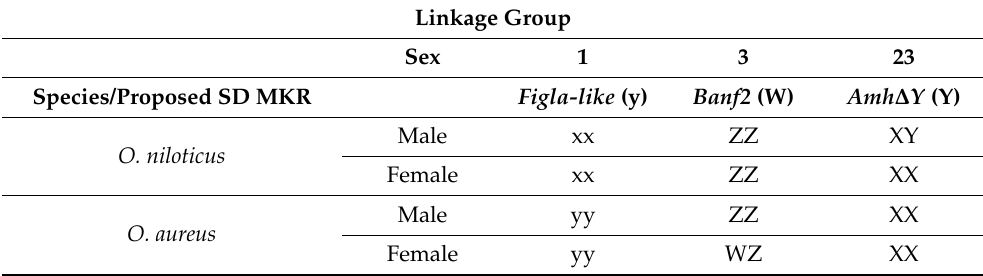
Table 5. The schematic allelic state of the SD systems for LGs 1, 3 and 23 in O. niloticus and O. aureus 1 . Linkage